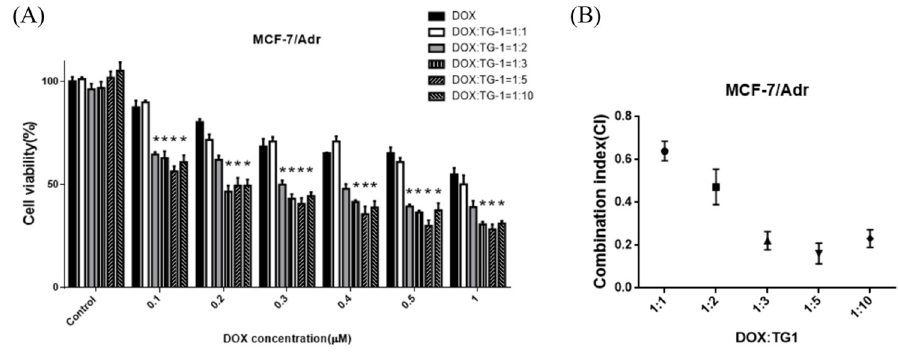
Fig 6. Combined effects of TG1 and DOX on inhibiting cell proliferation of MCF-7/Adr for 24 hours. (A)The cells were treated to different concentrations of DOX or combined with the chemosensitizer, TG1, in molar ratios of 1:1, 1:2, 1:3, 1:4 1:5 and 1:10. (B) Combination index of DOX and TG1 on different molar ratio for treating MCF-7/Adr cells. Data are shown by mean ± SD, n = 5. � p < 0.01, indicating significant differences between experimental and control